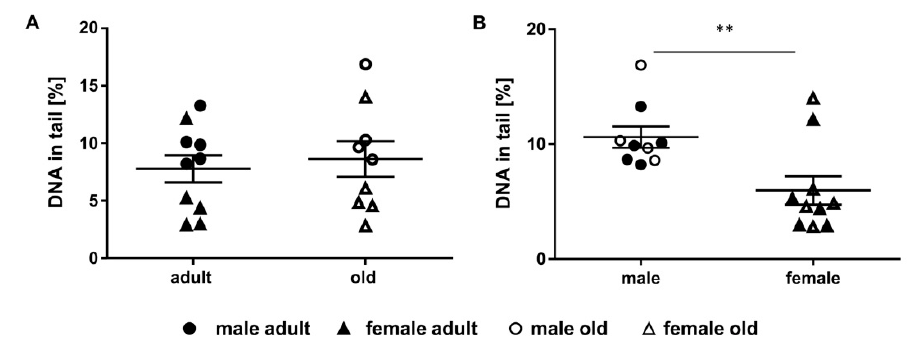
Figure 5. Impact of age and sex on DNA damage levels. Shown is DNA in tail (individual single measurement scores (two technical replicates) and group mean ± SEM) of murine liver of adult (24 weeks, n = 10) and old (109-114 weeks, n = 9) animals of both sexes (female: n = 10, male: n = 9). ( A ) adult versus old, ( B ) male versus female animals. t-test, ** p ≤ 0.01.